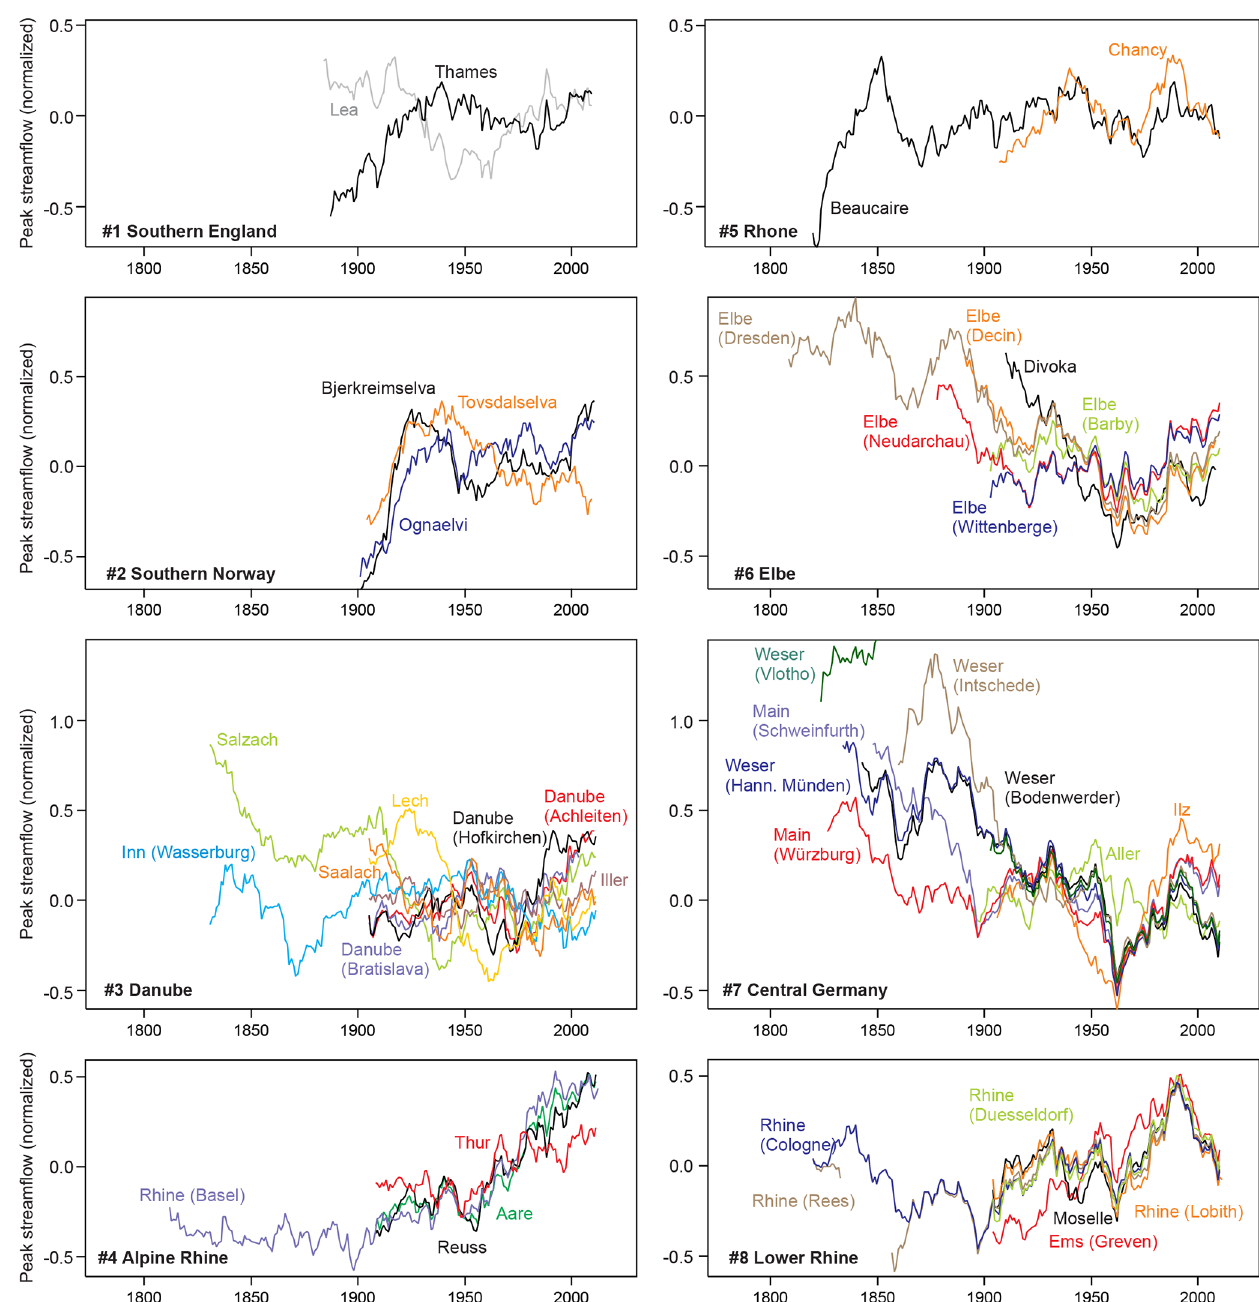
Figure 3. Normalized smoothed streamflow series for all series in all eight clusters. All series are smoothed with a 30-year moving